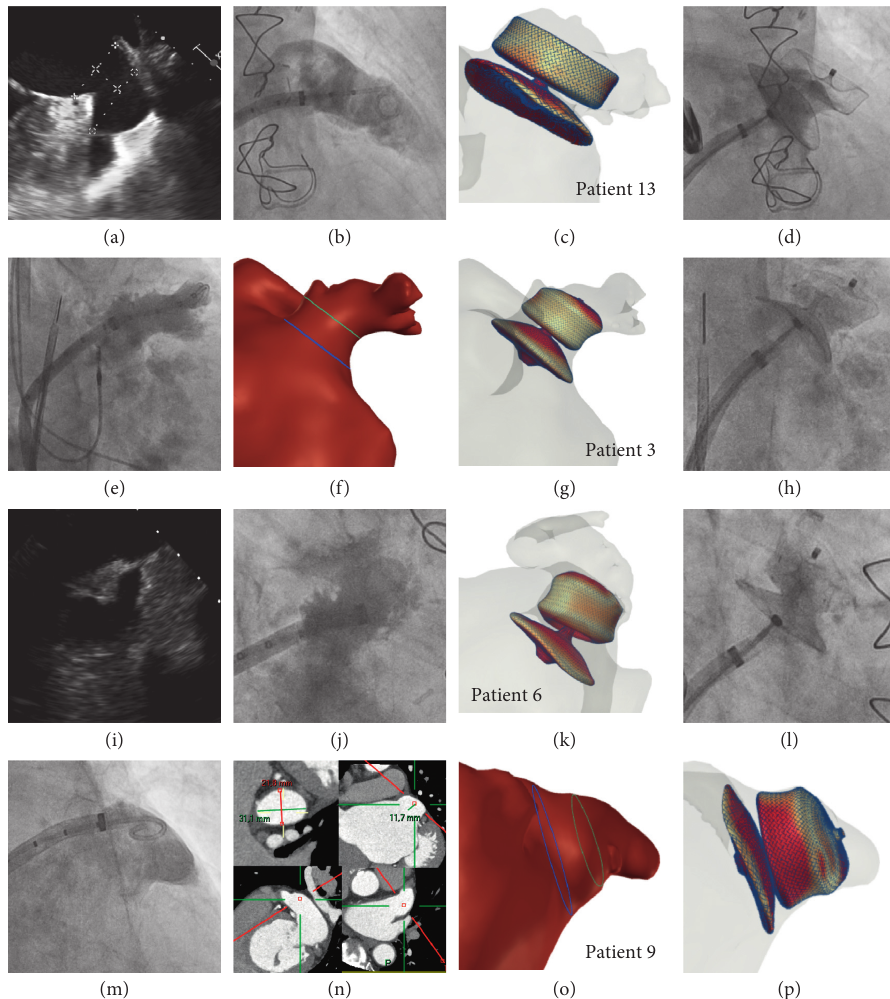
Figure 2: Case examples influenced by FEops. (a–d): patient 13, with a very large appendage, with mean landing zone of 31mm on TOE (a), and chicken wing morphology with poor confidence (6 out of 10) for a 34 Amulet. FEops (c) confirmed good anchoring and sealing with a 34, with good angiographic results (d). (e–h): patient 3, implanted under local anaesthesia with intracardiac echocardiography. Windsock morphology on angiography (e) and 3D volume (f). Although initial assessment with CT (landing zone 16 × 18mm) decided for a 20mm, simulation with a 22 Amulet was preferred (g) with good angiographic results (h). (i–l): patient 6, reverse chicken wing morphology on TOE (i) and angiography (j), with an initial 22 Amulet selected based on TOE (3D landing zone 18 × 21 mm) and CT (landing zone 14 × 21 mm), but with a preferred 20 Amulet simulation (k) and good angiographic results once implanted (l). (m–p): patient 9, windsock with large os and almost no depth on angiography (m) and 3D volume (o), with landing zone 22 × 31mm on CT (n); a 31mm Amulet could not be implanted after multiple attempts. Note the absence of apposition (red) posterosuperior on the FEops simulation